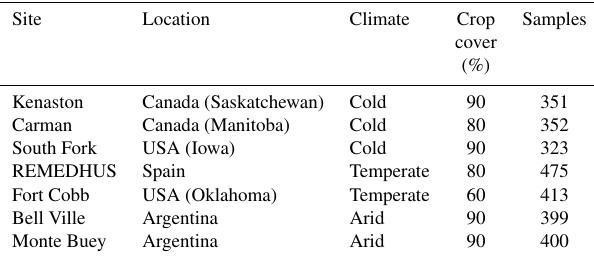
Table 2. Network sites from north to south, including their Koeppen–Geiger climate